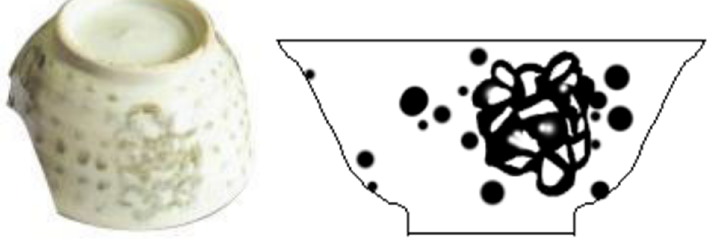
Figure 6. Ceramic blue and white decoration samples and drawings unearthed from Xiaopi kiln ceramics.